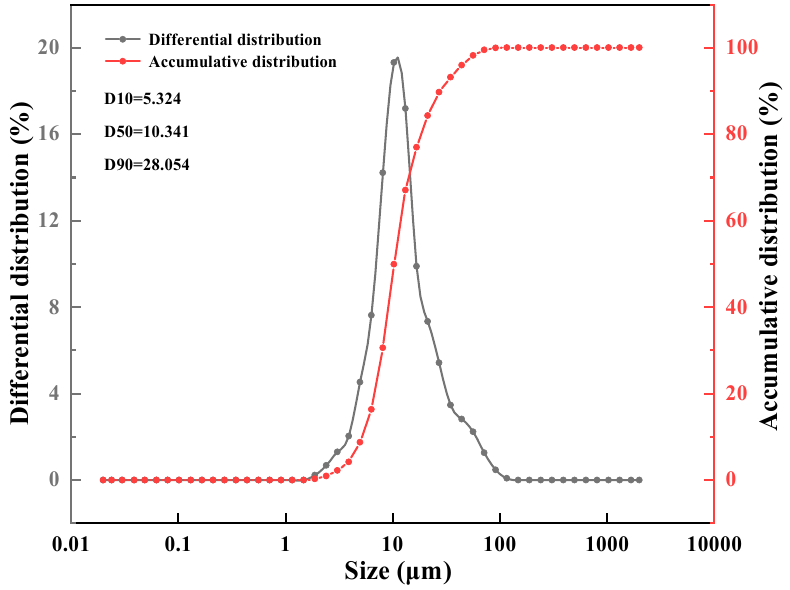
Figure 5. Particle size distribution of microcapsules in deionized water.